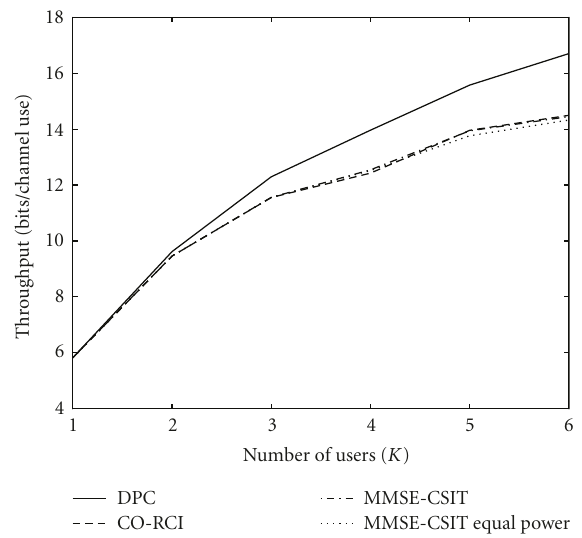
Figure 3: Comparison of optimal transmit beamforming CO-RCI and MMSE-CSIT beamforming for N t = 6, N r = 1, and P = 10 in a Rayleigh flat-fading channel. The optimal nonlinear preprocessing (DPC) is also shown for comparison.